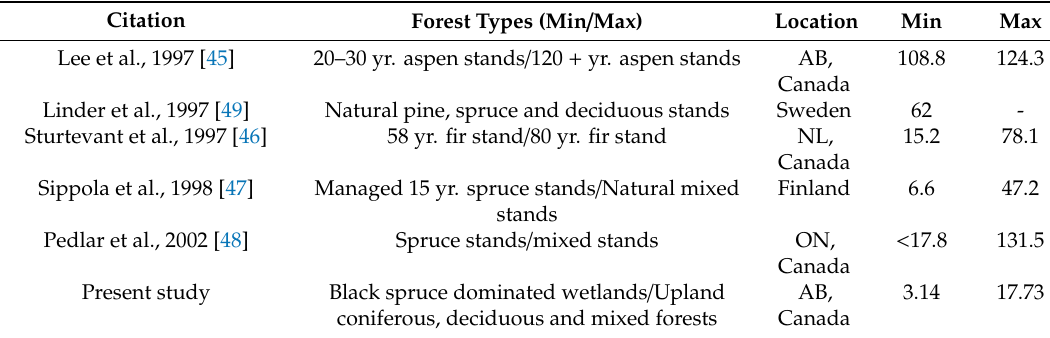
Table 6. Minimum and maximum average coarse woody debris volume (m 3 / ha) over varied boreal forest types presented in other studies. Note that the present study estimated volumes in 100 m 2 plots and upscaled the values for an estimate per hectare. Minimum value from Pedlar et al. [48] includes snags. Sturtevant et al. [46] values are for individual stands, while all other studies present